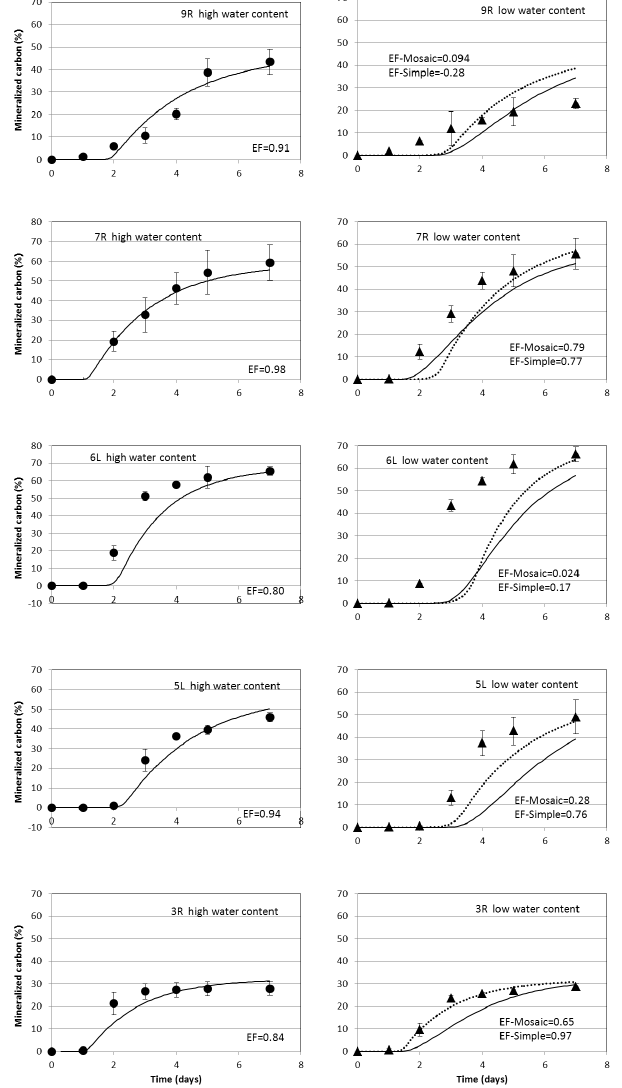
Figure 6: Experimental (symbols) and simulated (line) results for the 5 bacterial species Fig. 6. Experimental (symbols) and simulated (line) results for the five bacterial species inoculated at high and low water contents with inoculated at high and low water contents with their respective efficiency coefficients. For the their respective efficiency coefficients. For the low water content, simulations with 3-D Mosaic II and with a simpler approach using the moisture function of RothC model are displayed.